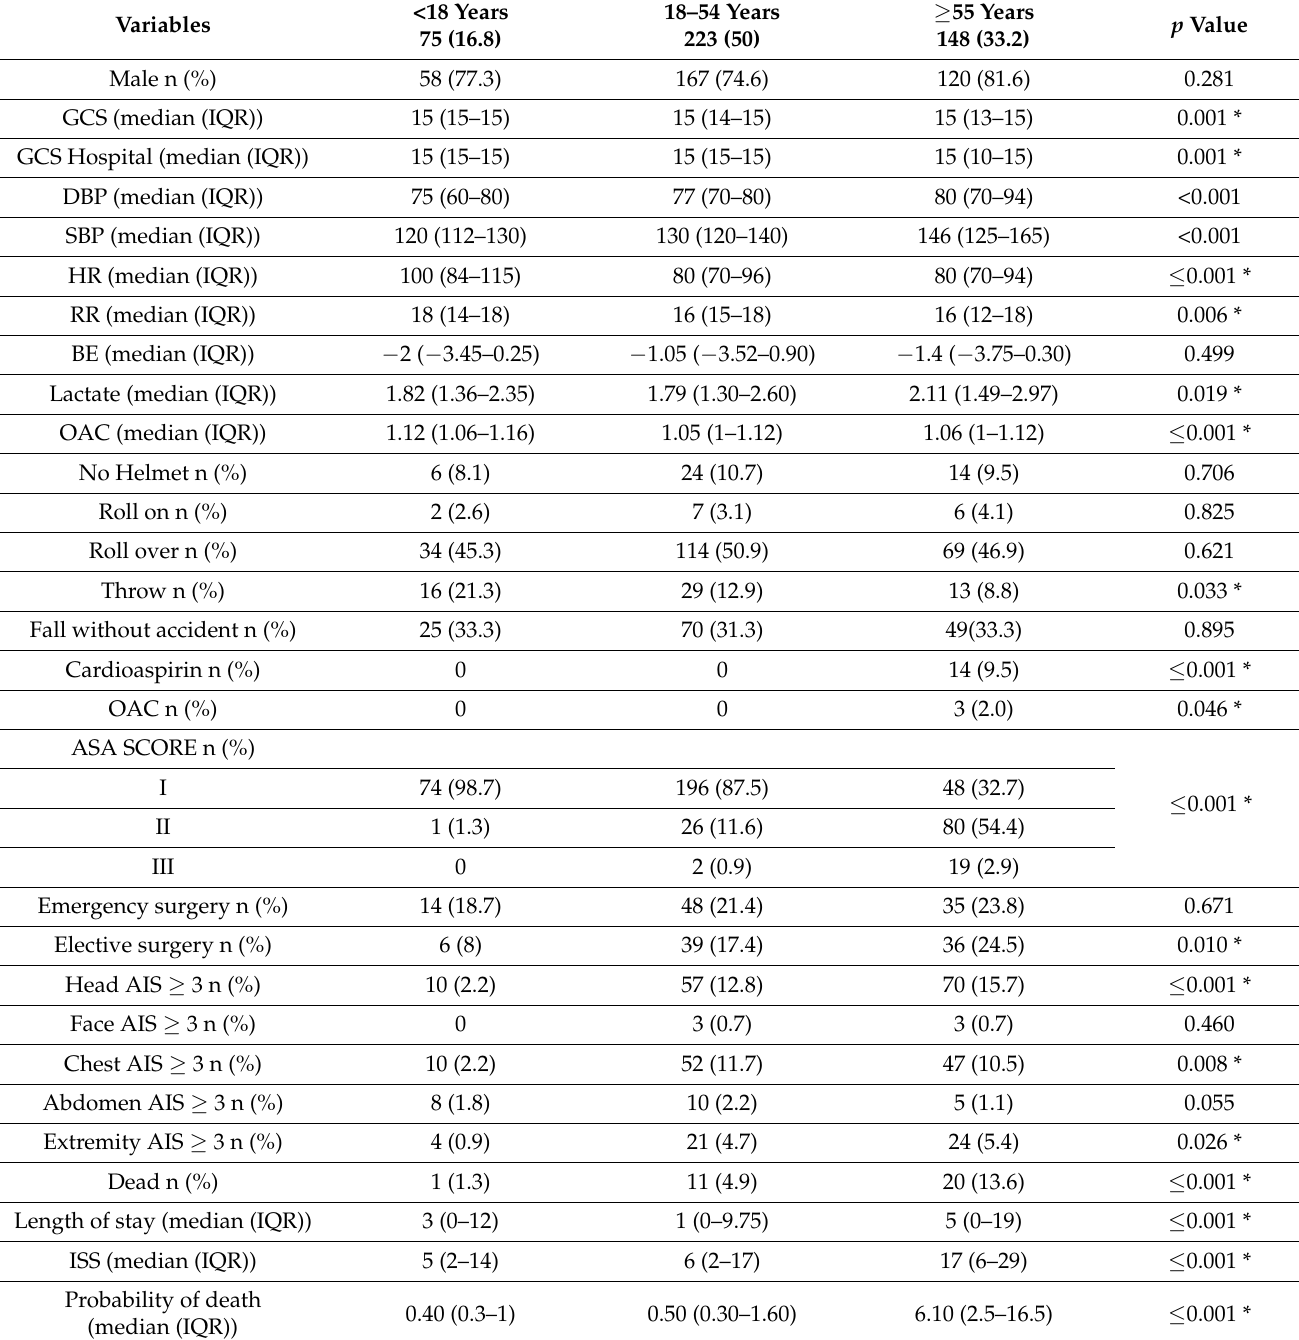
Table 1. Demographic and trauma-related